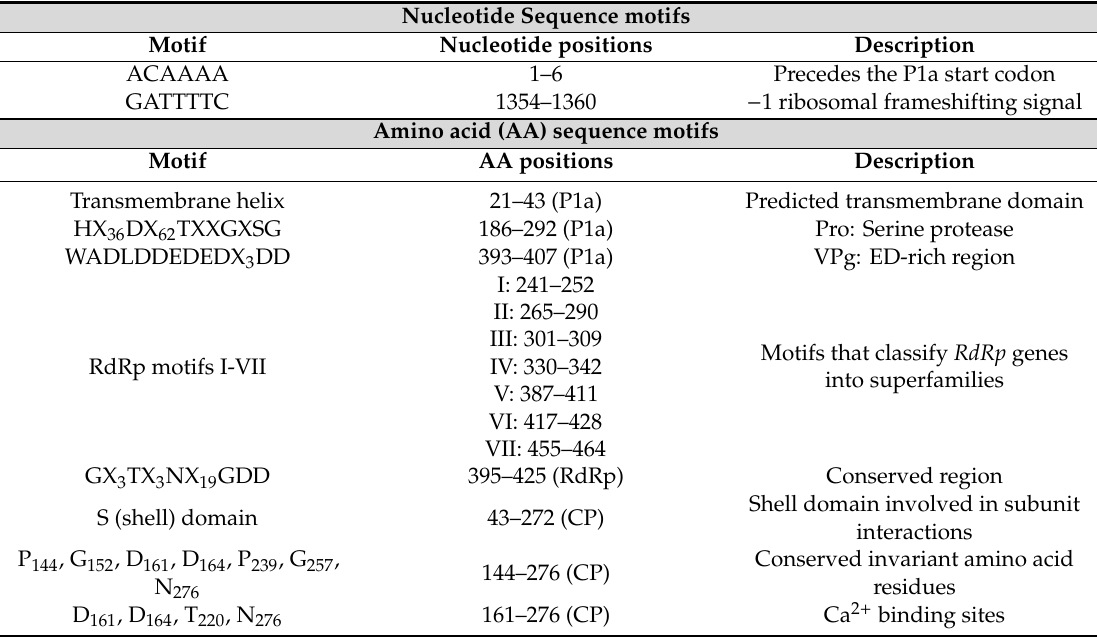
Table 1. Nucleic acid and amino acid sequence motifs identified in the genome of HuSRV1 based on the previously reported members in genus Sobemovirus